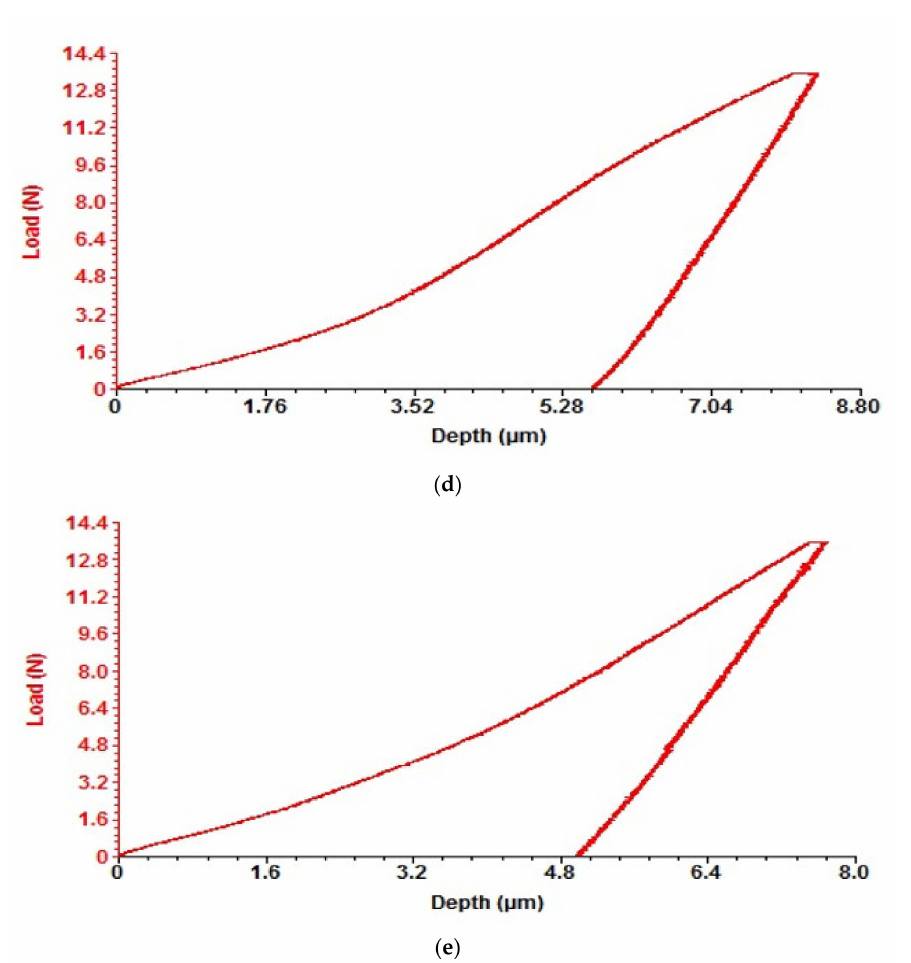
Figure 19. Microindentation tests for phosphate nodular cast iron sample. ( a ) Test 1, ( b ) Test 2, ( c ) Test 3, ( d ) Test 4, ( e ) Test